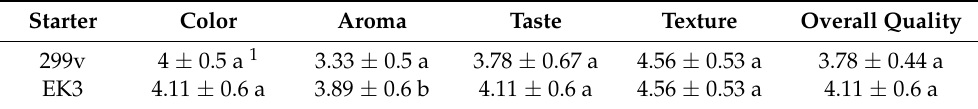
Table 7. Sensory evaluation of fermented mushrooms.